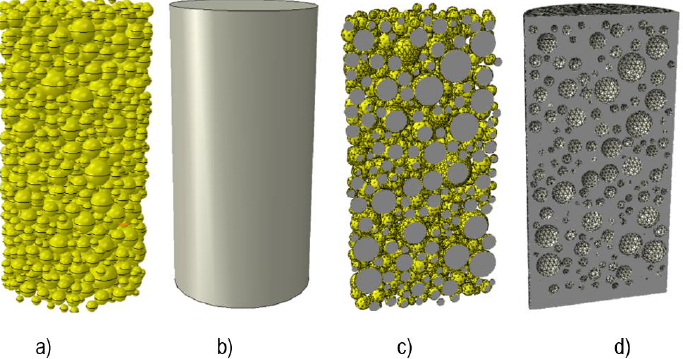
Figure 4. Phases in the model: ( a ) spatial distribution of the phase of spherical particles. ( b ) Mortar phase. ( c ) Vertical sectional view of the aggregates. ( d ) Vertical sectional view of the mortar.